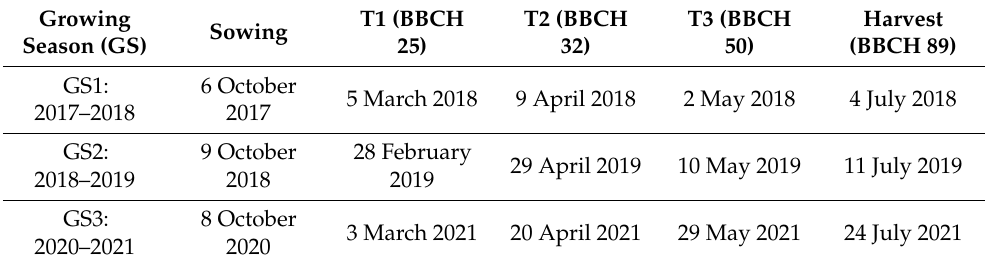
Table 4. Terms of sowing, fertilization, and harvest.